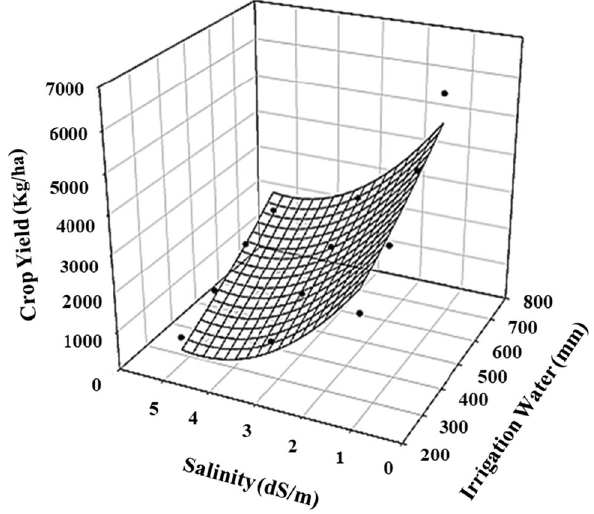
Fig. 8 Yield in kilograms per hectare (dry leaves) as a function of irrigation water and salinity of the used water based on real data in the studied